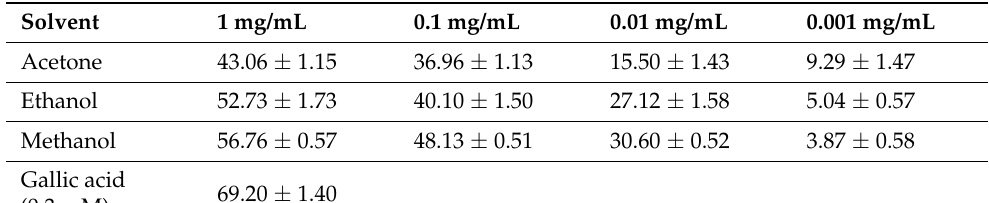
Table 2. Free radical scavenging activity of Coronopus didymus using DPPH assay (mean ± standard